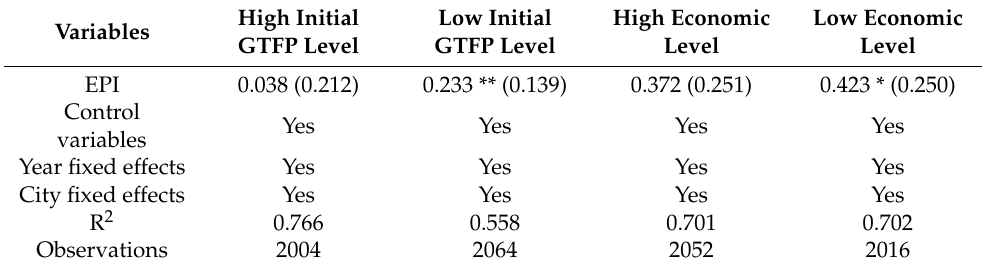
Table 5. Heterogeneity results across different initial GTFP levels and economic development